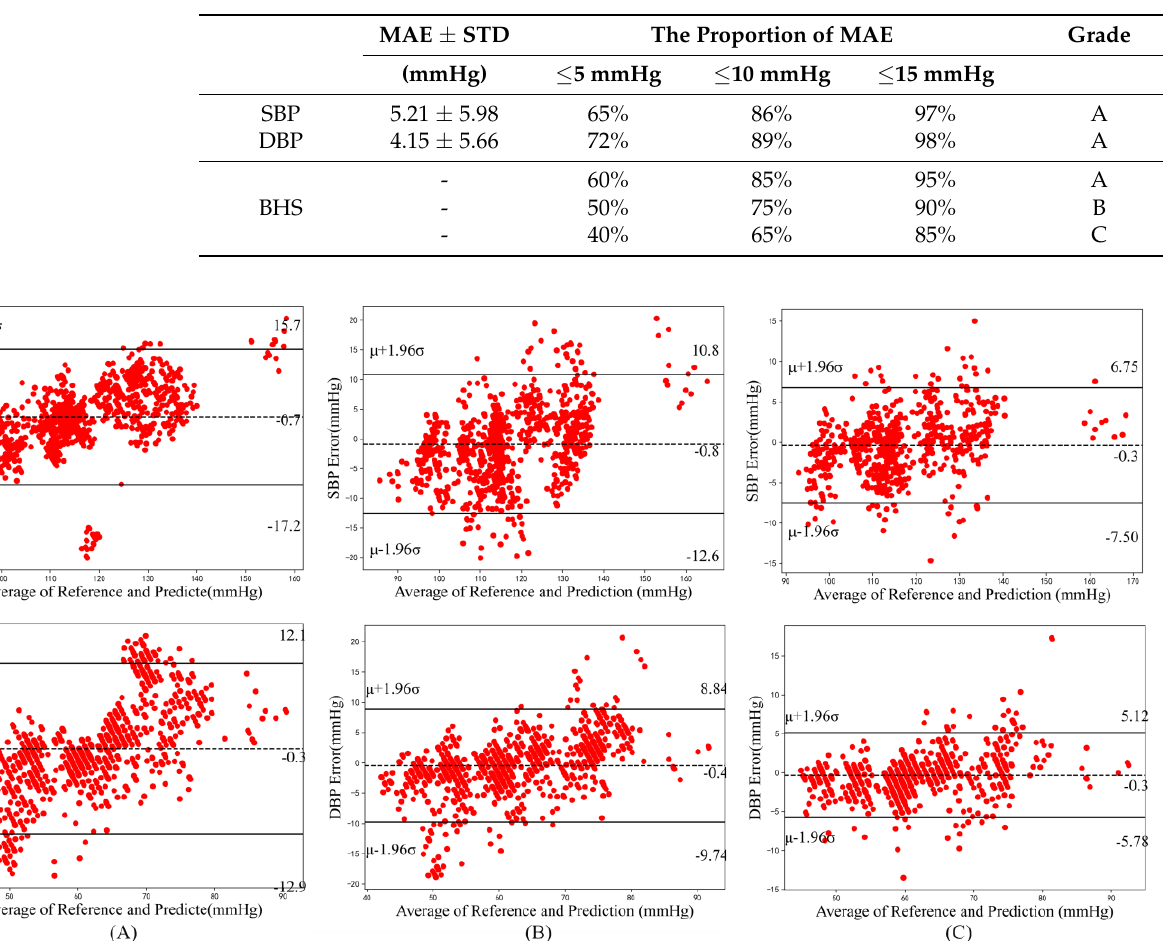
Table 4. The MAE and STD for SBP and DBP after calibration.